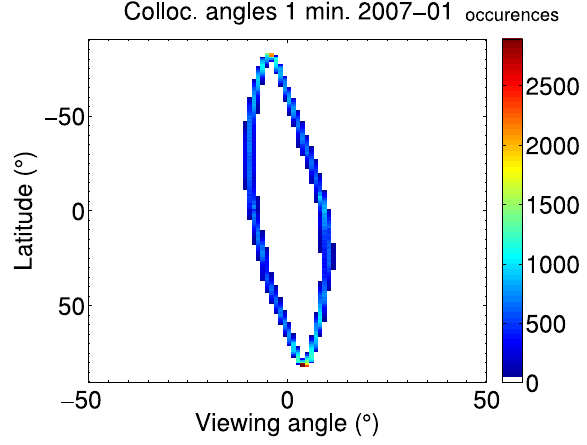
Fig. 4. This two-dimensional histogram shows at which angles the collocations between the NOAA-18 MHS and the CloudSat CPR occured in January 2007. The figure shows collocations with a max- imum time interval of 1min.